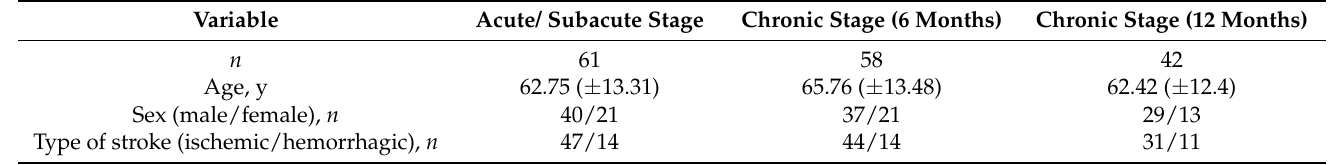
Table 1. Characteristics of participants.